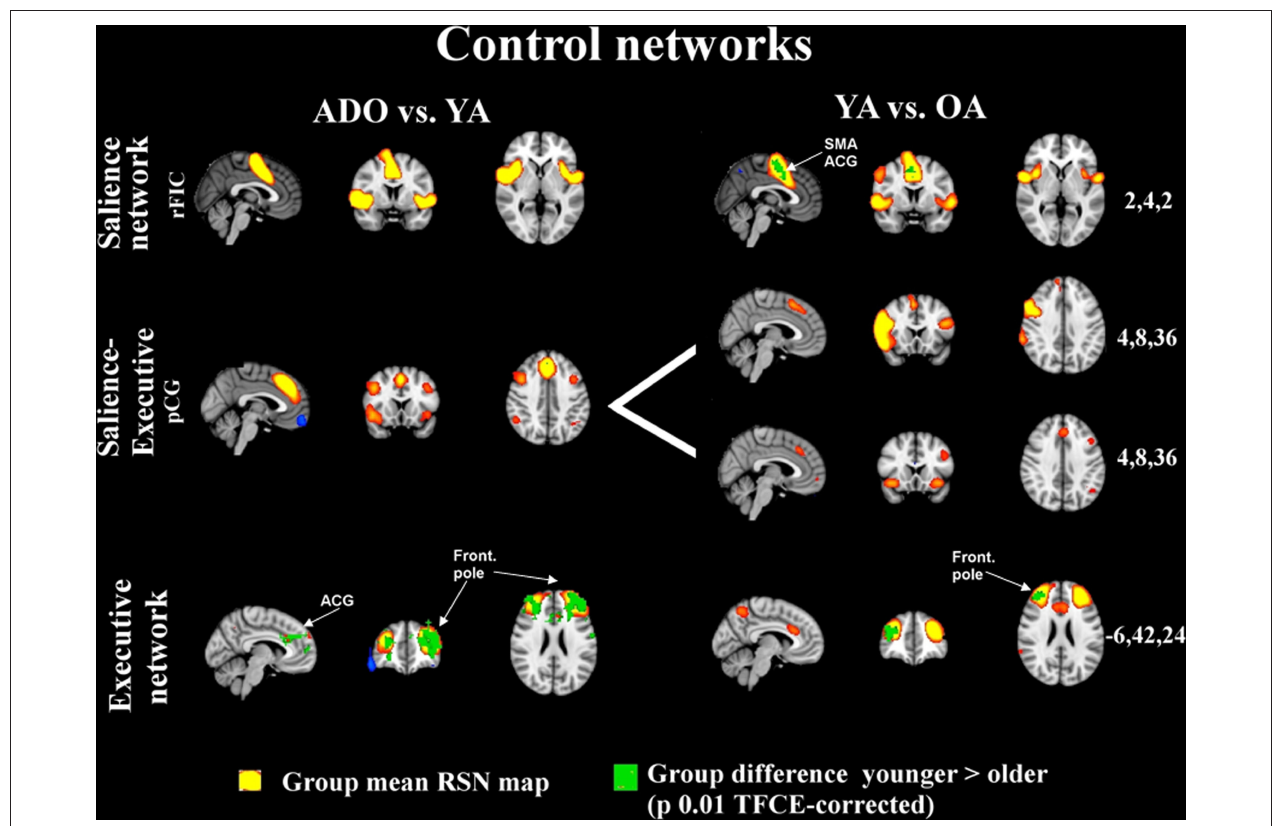
Figure 2 | The salience and executive control networks are show with identical thresholding as in Figure 1. It is notable that adolescents and younger adults have a salience-executive signal source which is separated into two components in the older adults. SMA, supplementary motor area; ACG, anterior cingulate